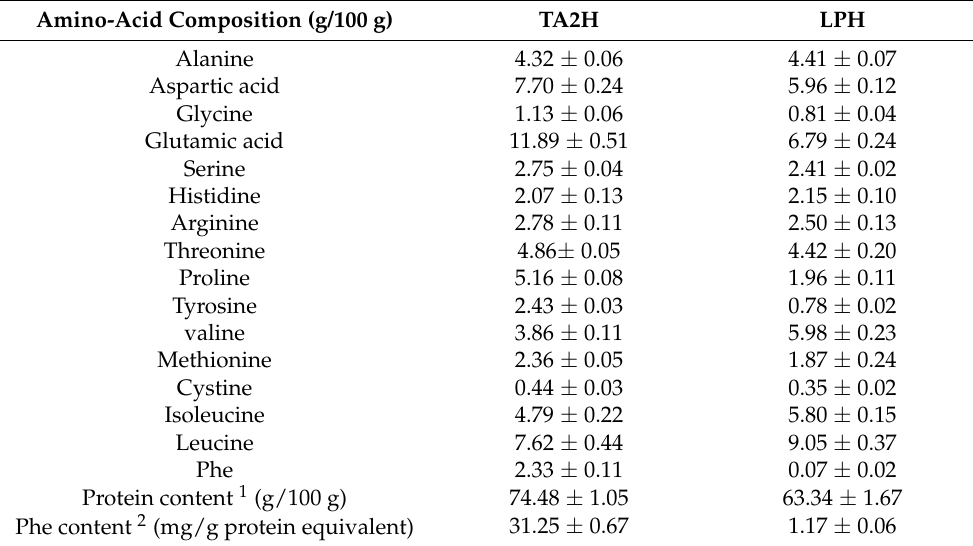
Table A1. Amino-acid compositions of whey protein